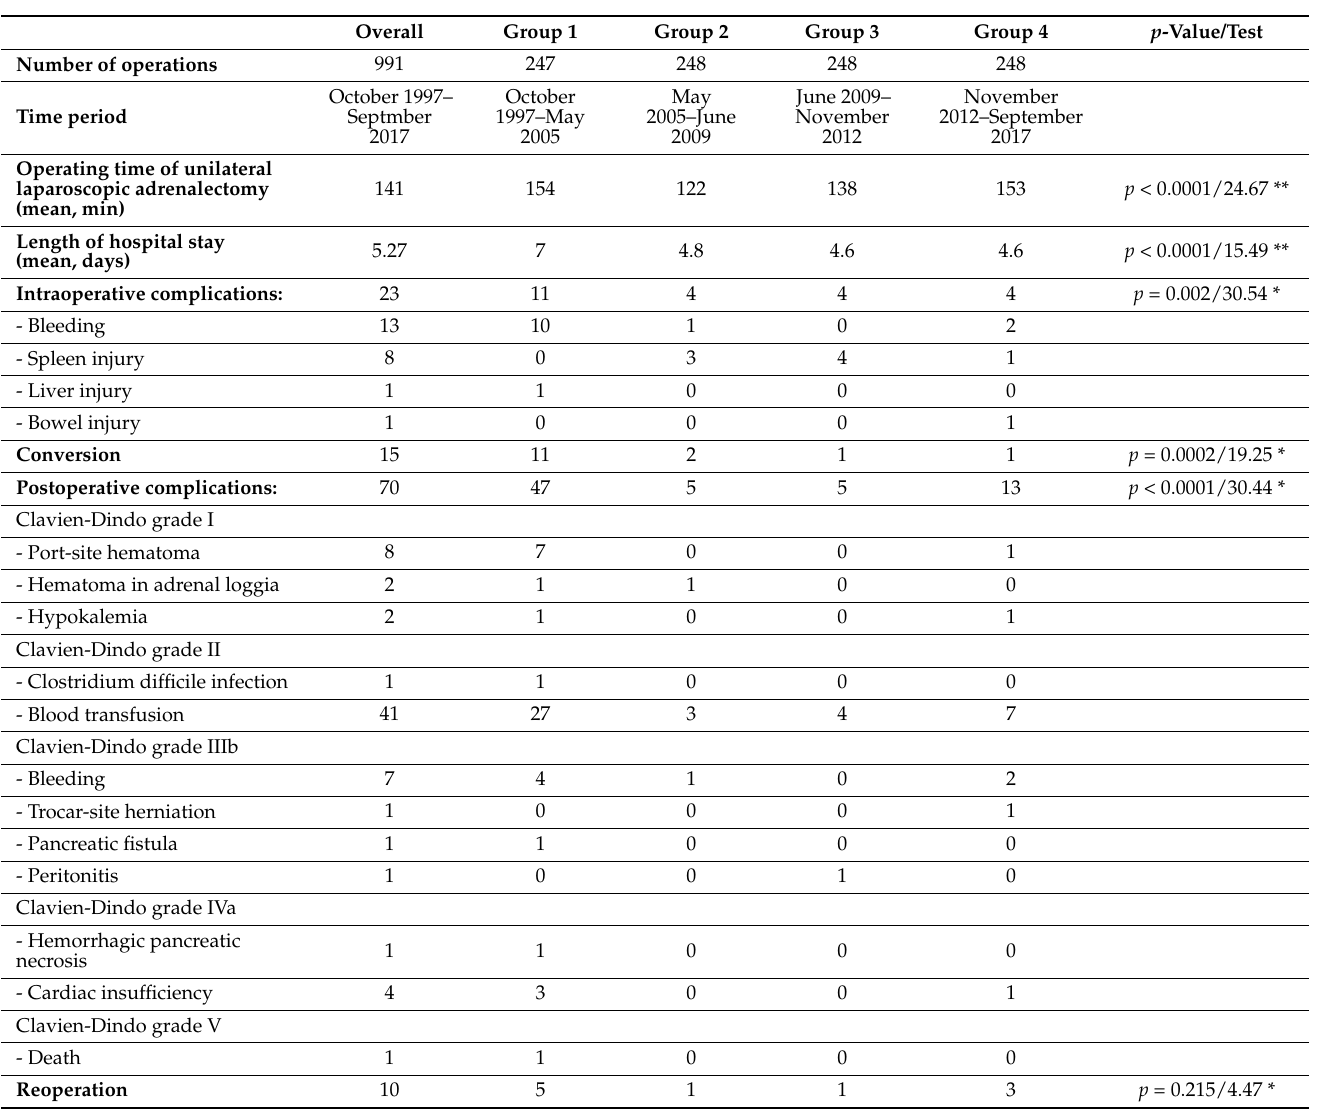
Table 2. Perioperative